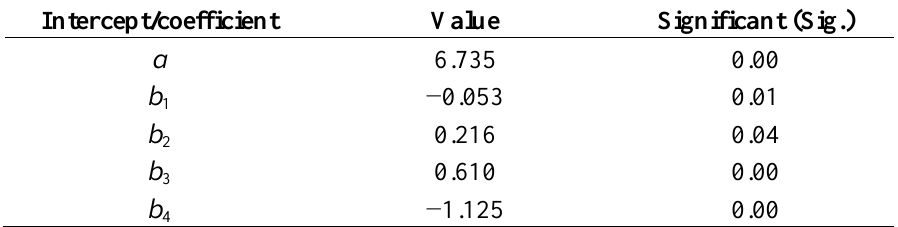
Table 7. Coefficient table for model predicting UPF